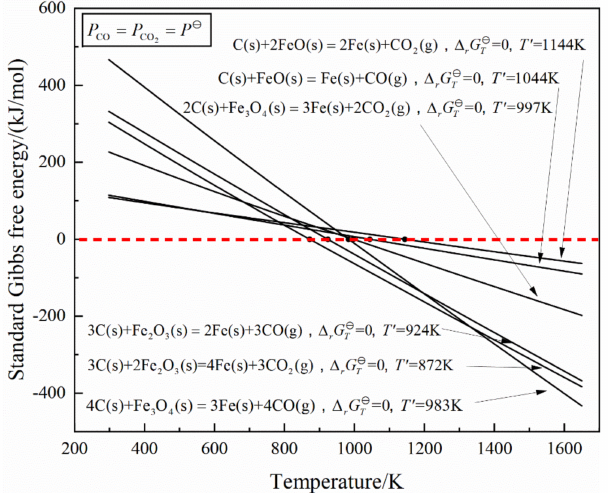
Figure 3. The standard Gibbs free energy and lowest reaction temperature of reduction reactions between carbon and iron oxides with single gas product